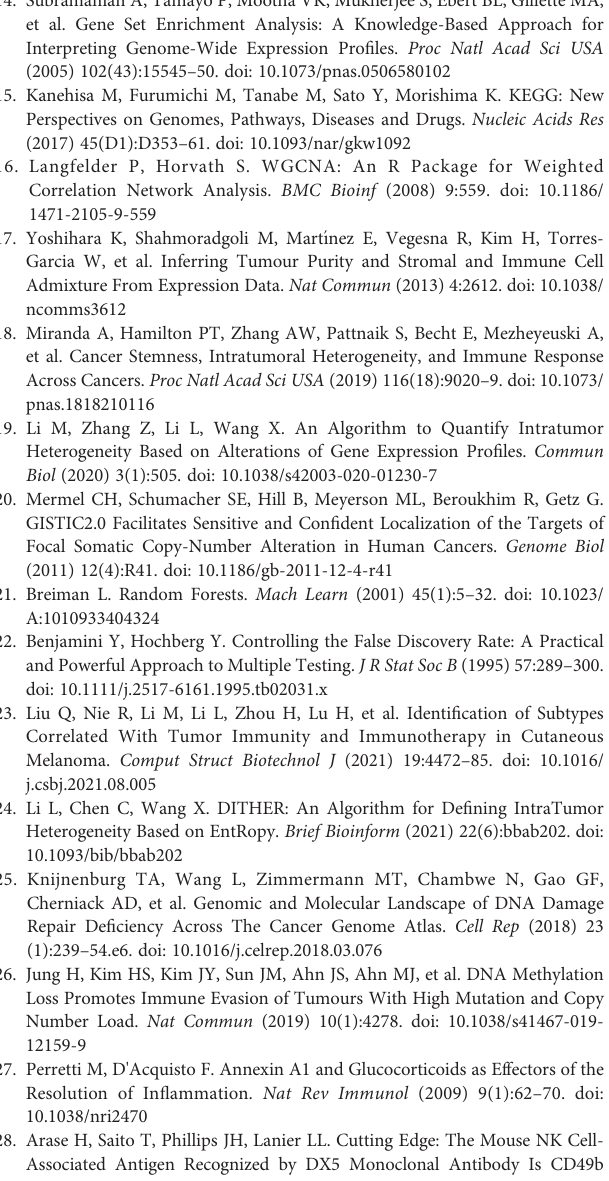
Supplementary Figure 1 | Comparisons between the HPV+ cervical cancer subtypes and HPV- tumors. Higher enrichment levels of immune signatures (A) , ratios of immunostimulatory/immunosuppressive signatures (CD8+ T cells/MDSCs) (B) , expressionlevelsofhumanleukocyteantigen(HLA)genes (C) ,andimmunescores (D) in HPV+G2 than in HPV- cervical cancers. (E) Comparisons of ITH scores, stemness scores,andglobalmethylationlevelsamongcervicalcancersubtypes.TheK – Worone- way ANOVA test (A, C) , two-tailed Student ’ s t test (B) , and one-tailed Mann – Whitney U test (D, E) P values are indicated. * P < 0.05, ** P < 0.01, *** P <